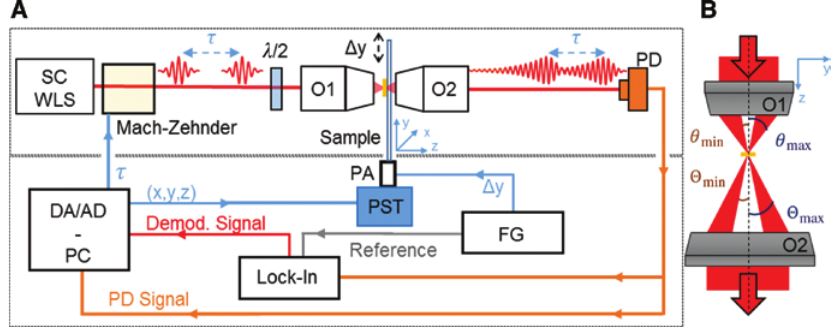
Figure 1: Schematic description of the Fourier-transform spatial modulation spectroscopy (FT-SMS) set-up. (A) The upper box represents the optical part, and the electronic set-up is depicted in the lower part. A pair of linearly polarized, ultra-broad- band laser pulses from a supercontinuum white light source (SC WLS) with adjustable time delay τ is focused to a diffraction-limited spot onto the sample using an all-reflective objective (O1). The polarization state of the incident pulse pair is controlled using an achromatic half wave plate ( λ /2). The transmitted light is collected by a second all-reflective objective (O2) and focused onto a photodiode (PD). The gold nanorod sample is positioned by a PC-controlled, three-axis piezo stage (PST). A piezo actuator (PA) driven by a function generator (FG) peri- odically modulates the sample in the vertical, y -direction. The voltage from the photodiode PD and the demodulated signal from a phase- sensitive lock-in amplifier are simultaneously recorded by an analog-to-digital (AD) converter card and fed into the PC. (B) The illustration of the minimum and maximum acceptance angles of the focusing and collecting